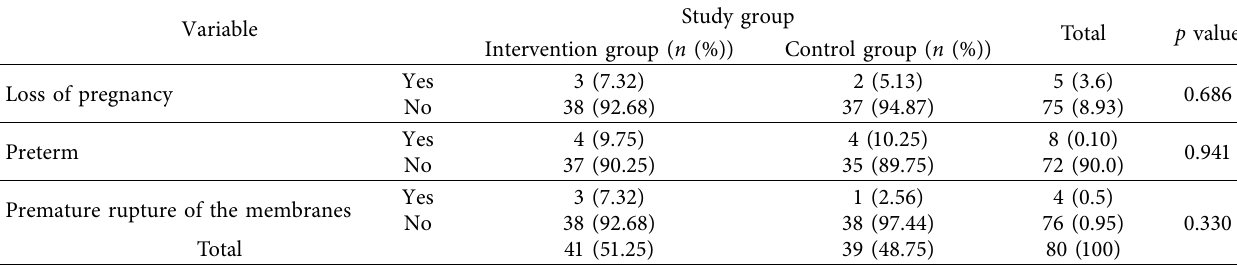
Table 4: Comparison of short-term pregnancy complications between the two groups.